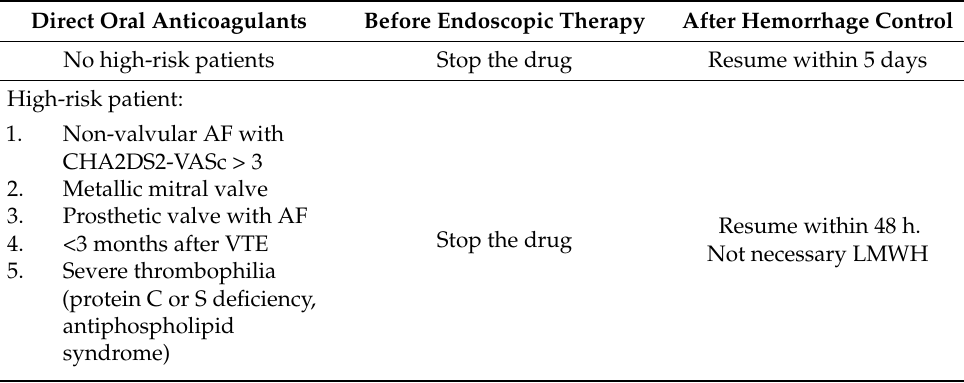
Table 5. Direct oral anticoagulants management in non-variceal upper